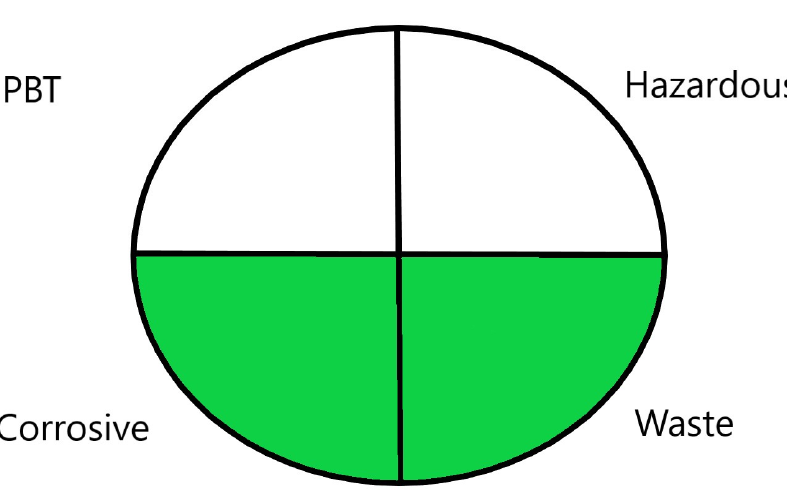
Figure 1. NEMI evaluation pictogram results for all evaluated chromatographic